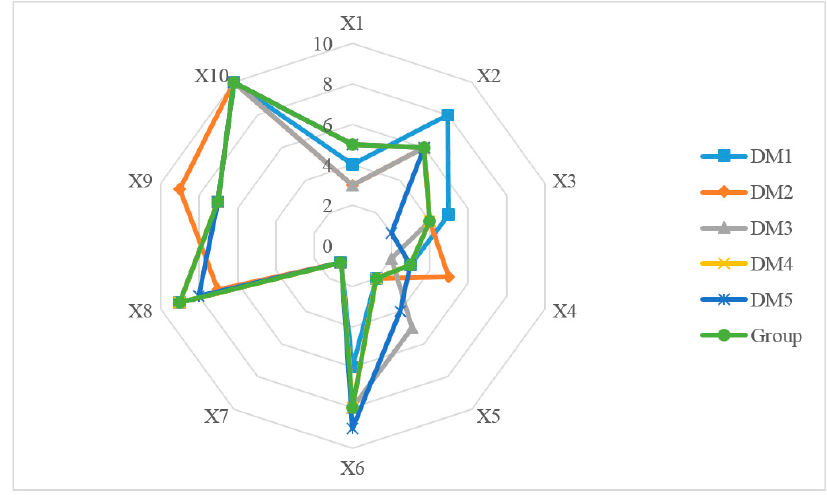
Figure 5. The individual ranking and group ranking for 10 mobile medical APPs.